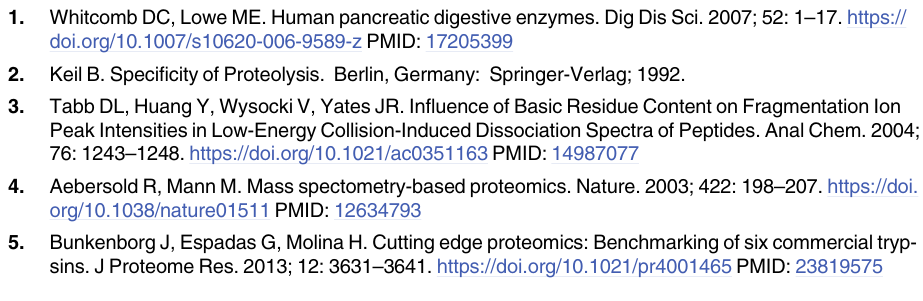
S1 Table. List of proteins identified in each trypsin preparation: Crude Sigma IX-S, enhanced (methylated) Sigma IX-S and PSG (Promega sequencing